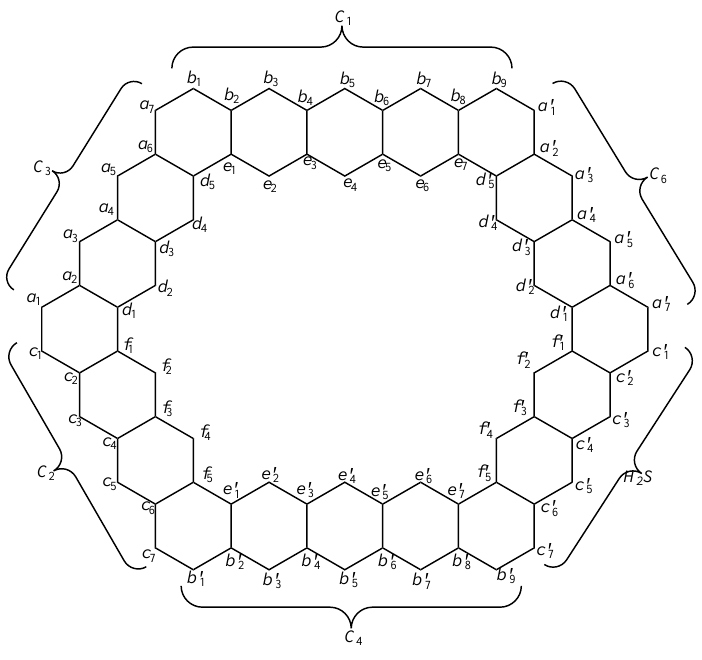
Figure 1. Hollow Coronoid with C 1 = 5, C 2 = C 3 =